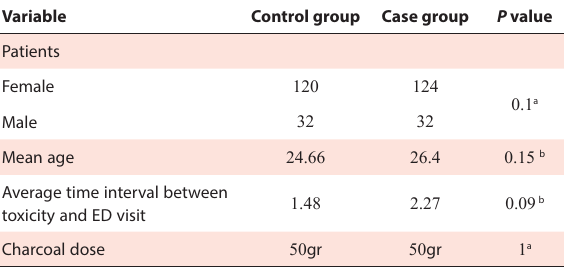
Table 1. Demographic data, mean time interval between toxicity and ED visit and Charcoal